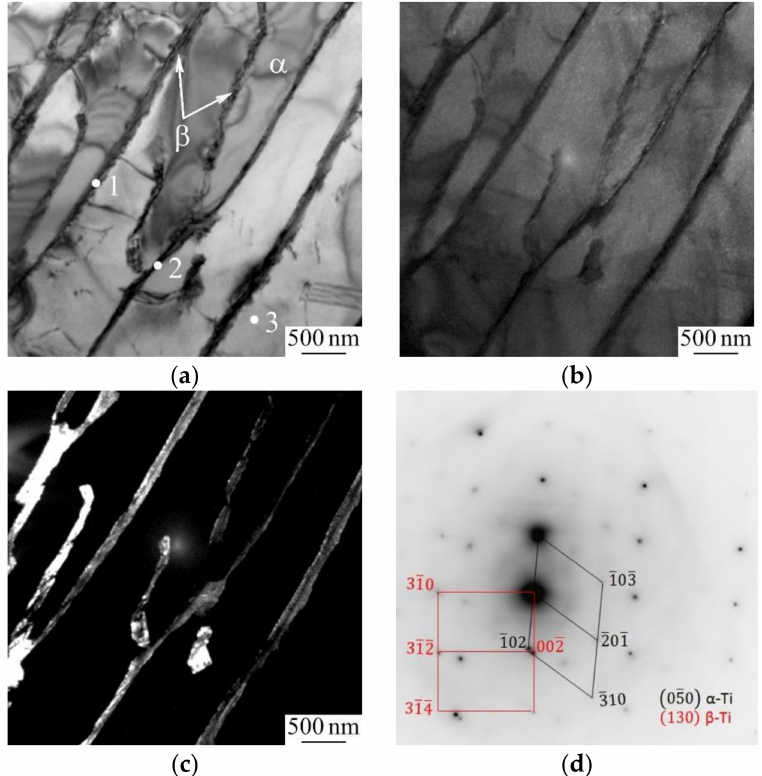
Figure 3. TEM bright ( a ) and dark-field micrographs ( b , c ) and the associated selected area electron diffraction (SAED) pattern with an indexing scheme ( d ) of the wrought Ti-6Al-4V sample. The dark- field TEM micrographs were obtained with the 211 ( 251 ) α -Ti ( b ) and 310 ( 130 ) β -Ti reflections ( c ). Table 2. Elemental composition of the wrought Ti-6Al-4V sample at the points shown in Figure 3a.